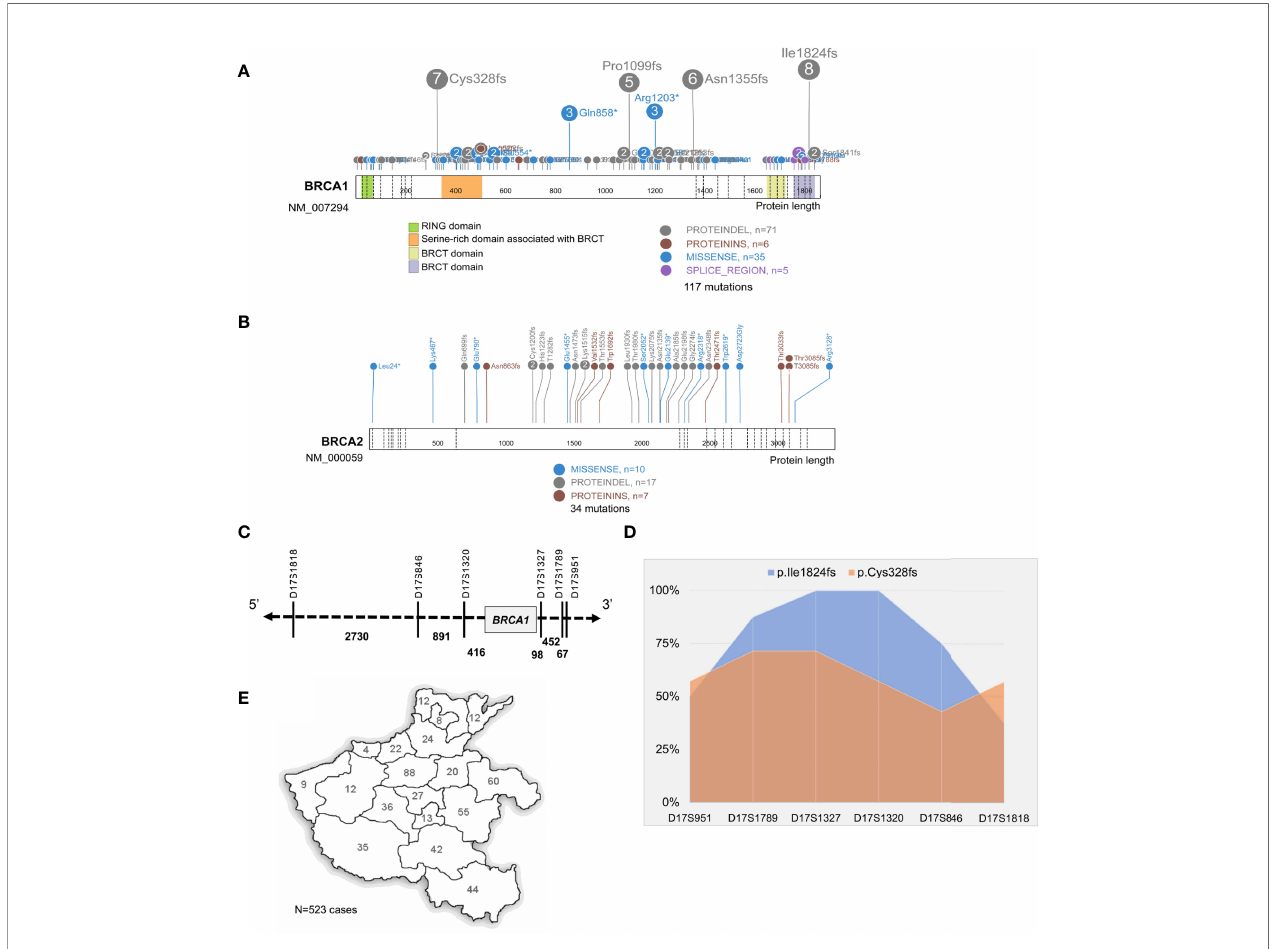
FIGURE 2 | Identi fi cation of BRCA1 :c.5470_5477del as the founder mutation in Henan OC patients. Protein paint shows the pathogenic and likely pathogenic mutations detected in BRCA1 ( A ) and BRCA2 (B) from 530 Henan OC patients. (C) A schematic diagram illustrates the genomic location of BRCA1 and its fl anking STR markers selected for haplotype analysis. (D) Haplotype analysis of six STR markers across 8 BRCA1 :c.5470_5477del (p.lle1824fs) carriers (blue) and seven BRCA1 :c.981_982del (p.Cys328fs) carriers (orange). STR loci are indicated on x-axis and the proportion of patients sharing the same allele is indicated on Y-axis. (E) A map shows the places of origin of the patients in this OC